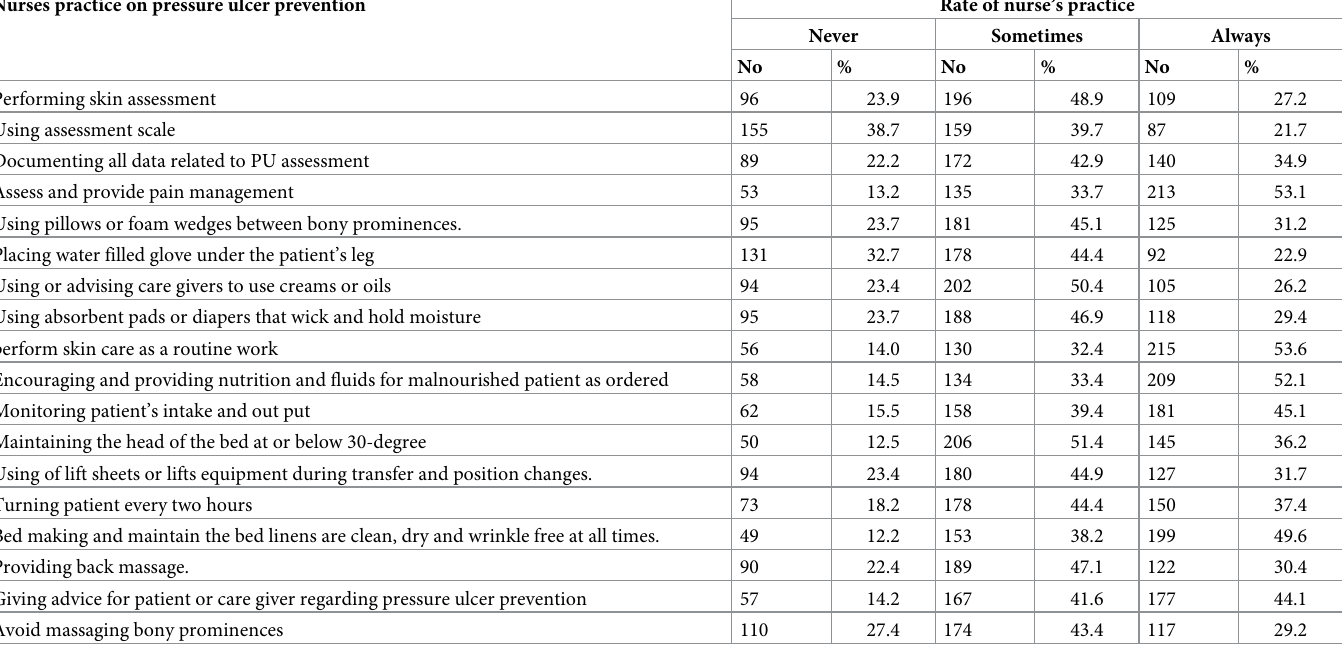
Table 3. Pressure ulcer prevention practice among nurses working in public hospitals of Harari regional state and Dire Dawa city administration, Eastern Ethiopia, 2018 (n = 401). Nurses practice on pressure ulcer